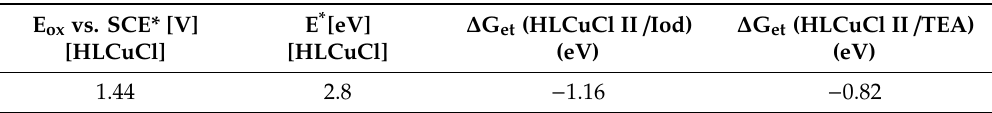
Table 2. Excited state energies E*, oxidation potentials E ox , and free energy change ( ∆ G et ) for the HLCuCl / TEA / Iod